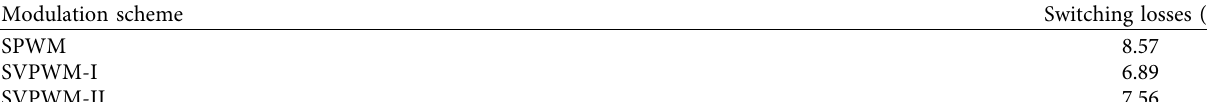
Table 11: Switching losses for three diferent modulation